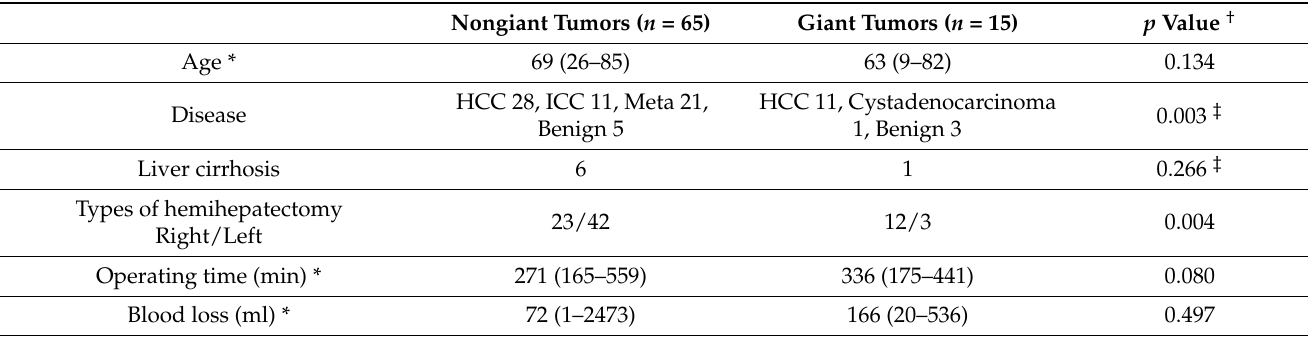
Table 2. Comparing the surgical outcomes for nongiant and giant liver tumors ( ≥ 10 cm) after laparoscopic